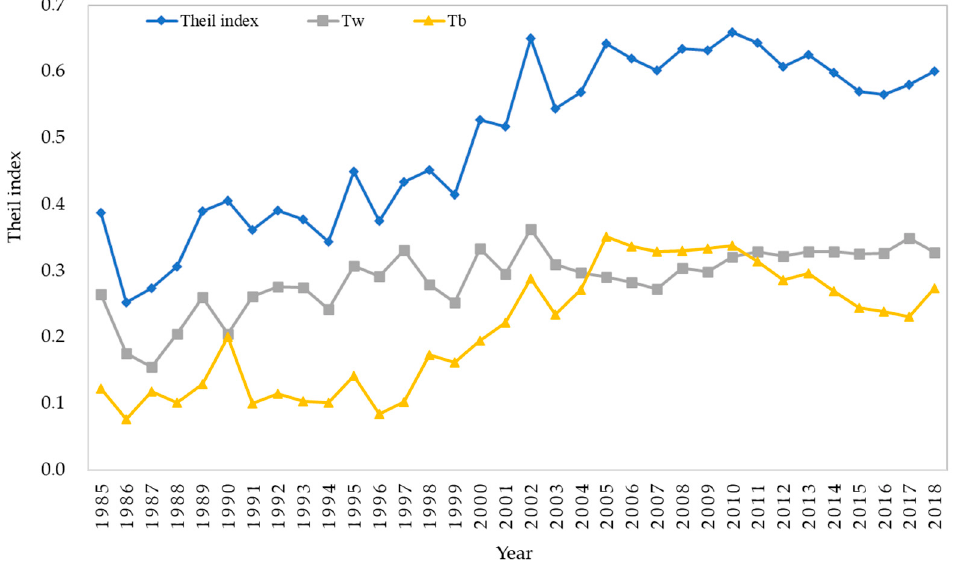
Figure 4. Theil index of green invention patent applications for the period 1985–2018.